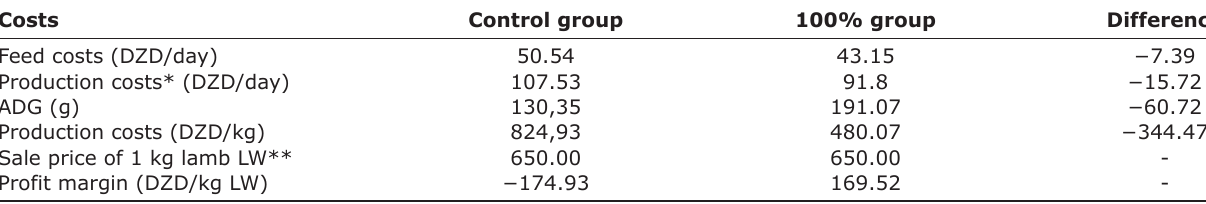
Table-9: Cost of producing 1 kg of live